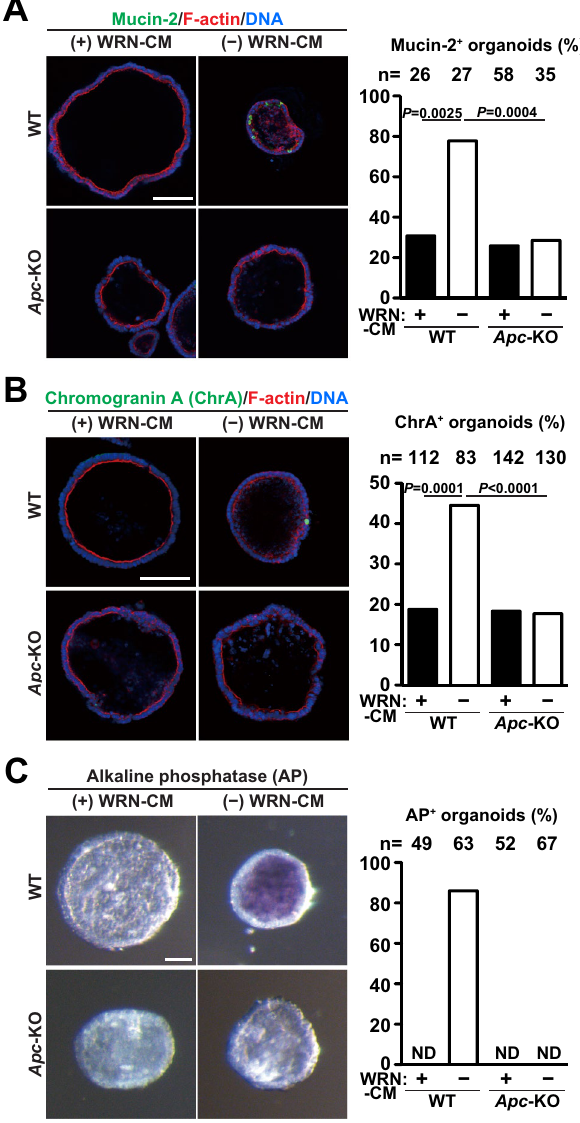
Figure 5. Suppression of cell differentiation in Apc -KO organoids. Organoids formed in the presence of WRN-CM were cultured in the presence or absence of WRN-CM for 3 more days. ( A , B ) The organoids were stained with anti-Mucin-2 antibody ( A , green) and anti-chromogranin A antibody ( B , green). Counter stain, phalloidin for F-actin (red) and DAPI for DNA (blue). The ratio of organoids containing at least one Mucin- 2-positive ( A ) and chromogranin A-positive ( B ) cells to total organoids was quantified for each group. The total number of organoids analyzed is shown above each bar. Dunn’s multiple comparison test was used after Kruskal–Wallis test to calculate P values. ( C ) Alkaline phosphatase activity (stained purple) was detected in the organoids. The ratio of organoids containing at least one alkaline phosphatase-positive cell to total organoids was quantified for each group. The total number of organoids analyzed is shown above each bar. ND not detected. Scale bar, 100